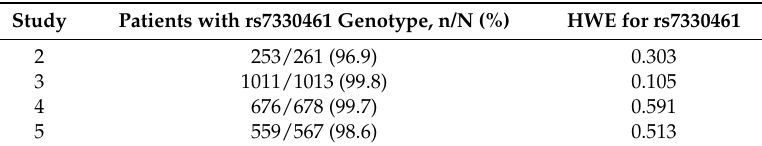
Table 3. Genotyping data